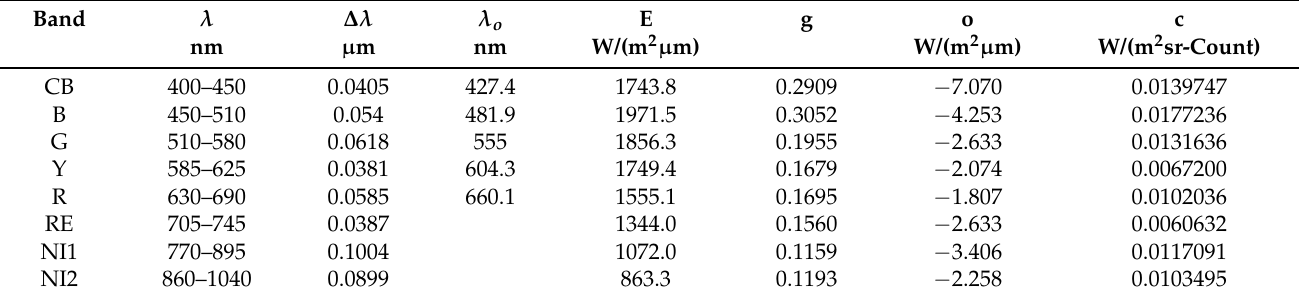
Table 1. Properties of the radiometric performance of WV-3